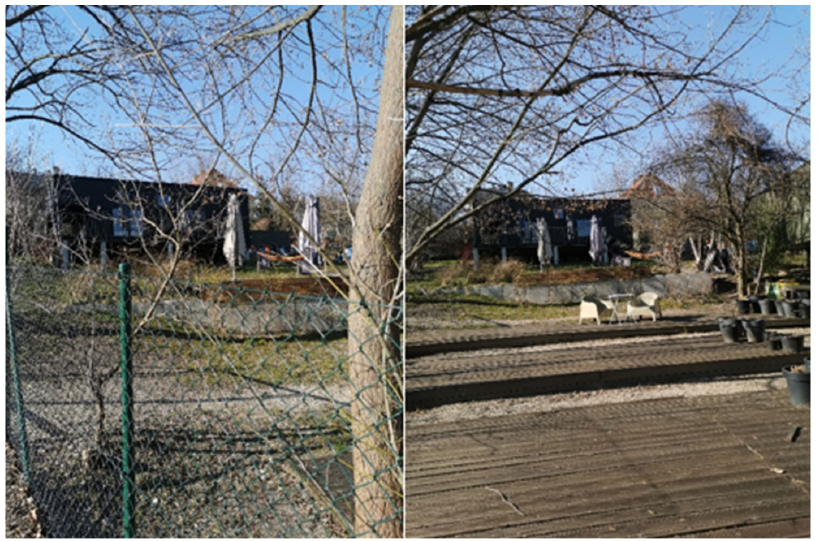
Figure 4. Szel ą g Garden, Pozna ń (Roman Andrzejak 2022).